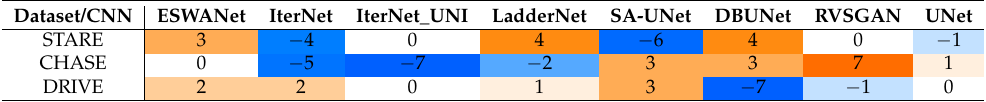
Table 6. CNN model ranking based on the Copeland score for each of the datasets. The larger the value is, the more significant the model is clinically. Absolute values of the Copeland score are in the [ − 8, 8]